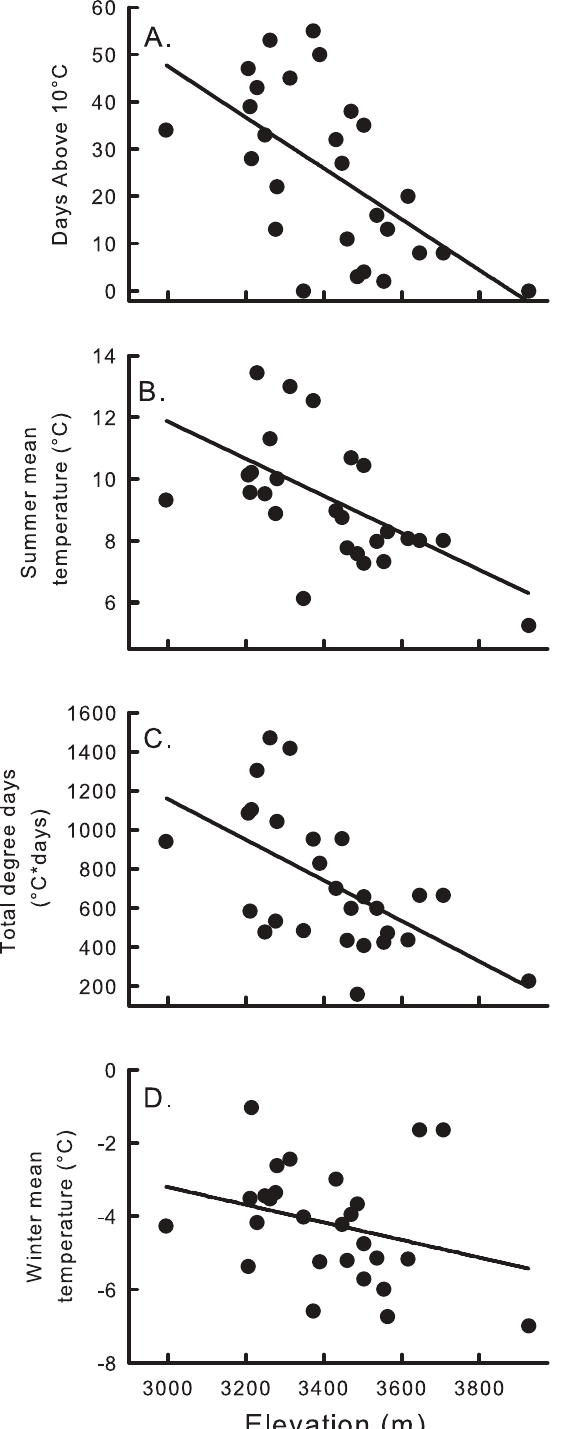
Fig 6. Correlations between American pika scat density and four local climate measures. Climate variables from top to bottom: number of days above 10°C, adj. r 2 = 0.06; mean summer temperature, adj. r 2 = 0.02; total degree days, adj. r 2 = 0.04; and mean winter temperature, adj. r 2 = 0.01; were obtained via ibutton sensors in the Wind River Range, Wyoming, USA deployed during August, 2010 – August 2011.